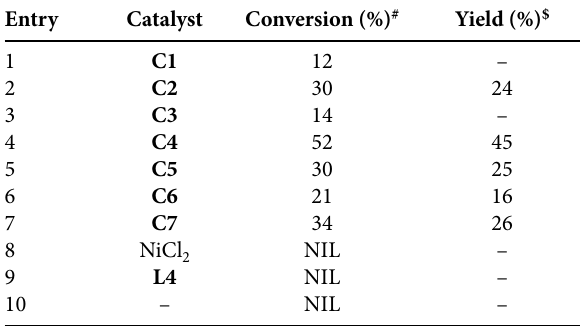
Table 1: Catalysis data for acceptorless dehydrogenation of 1-phe- nylethanol to yield acetophenone; catalyzed by